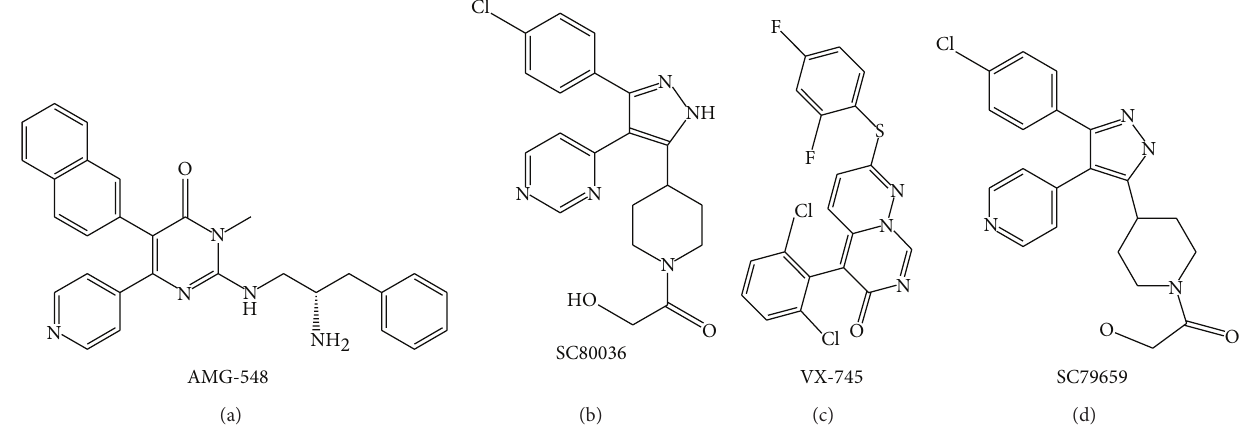
Figure2: Chemicalstructuresofrepresentativenovel p38inhibitors.Promisingtherapeuticactivities oftheseinhibitorsagainst inflammatory diseases such as RA encourage the continuous progression for clinical